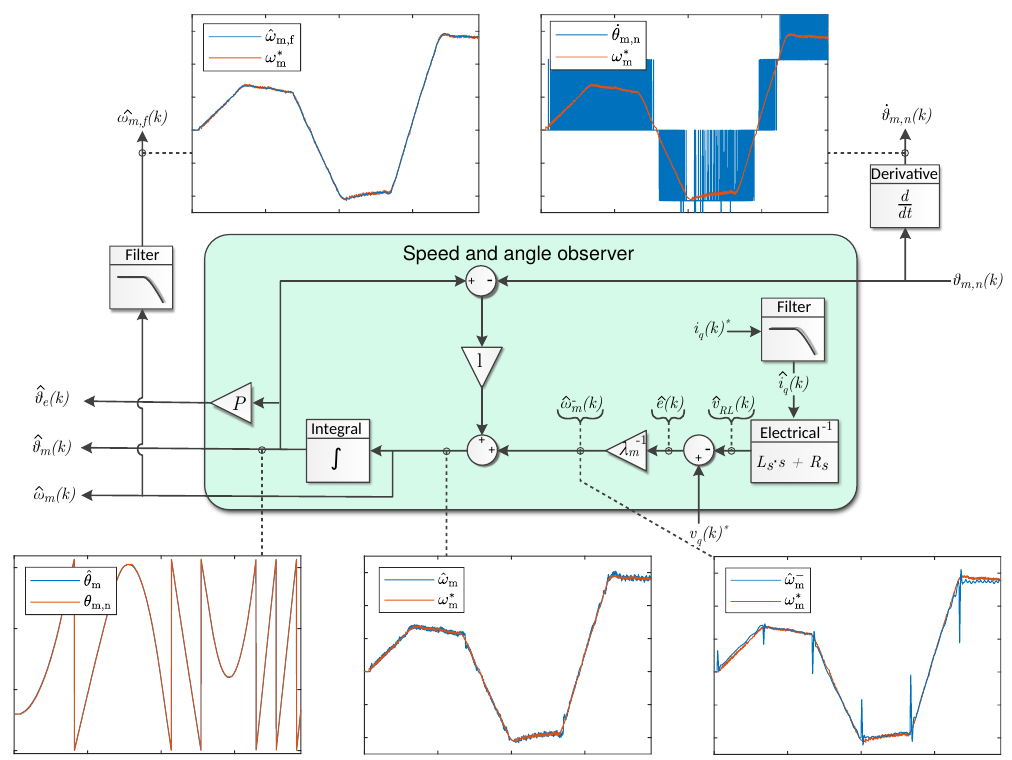
Figure 6. Illustration of the speed and angle observer including test results of the internal parameters. The first axis of all plots relates to time. The reference speed ω ∗ m is an estimate of the true speed, which is calculated by applying a 200Hz low-pass filter to the derivative of the raw angle ˙ θ m,n and then offset in time with an amount corresponding with the time-delay introduced by the